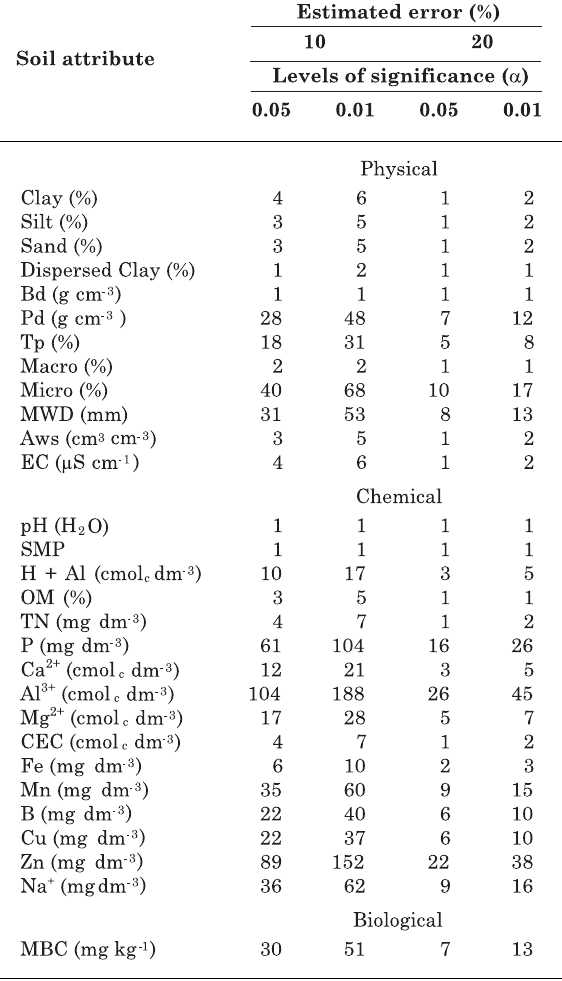
compose one sample of each soil property based on the estimated error around the mean, at two significance